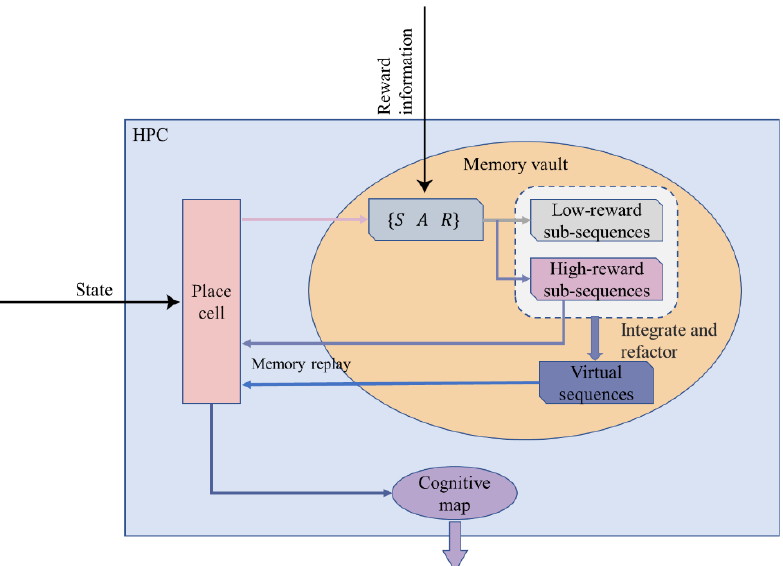
Figure 3. A detailed schematic diagram of the Memory-Replay Mechanism in the hippocampus.